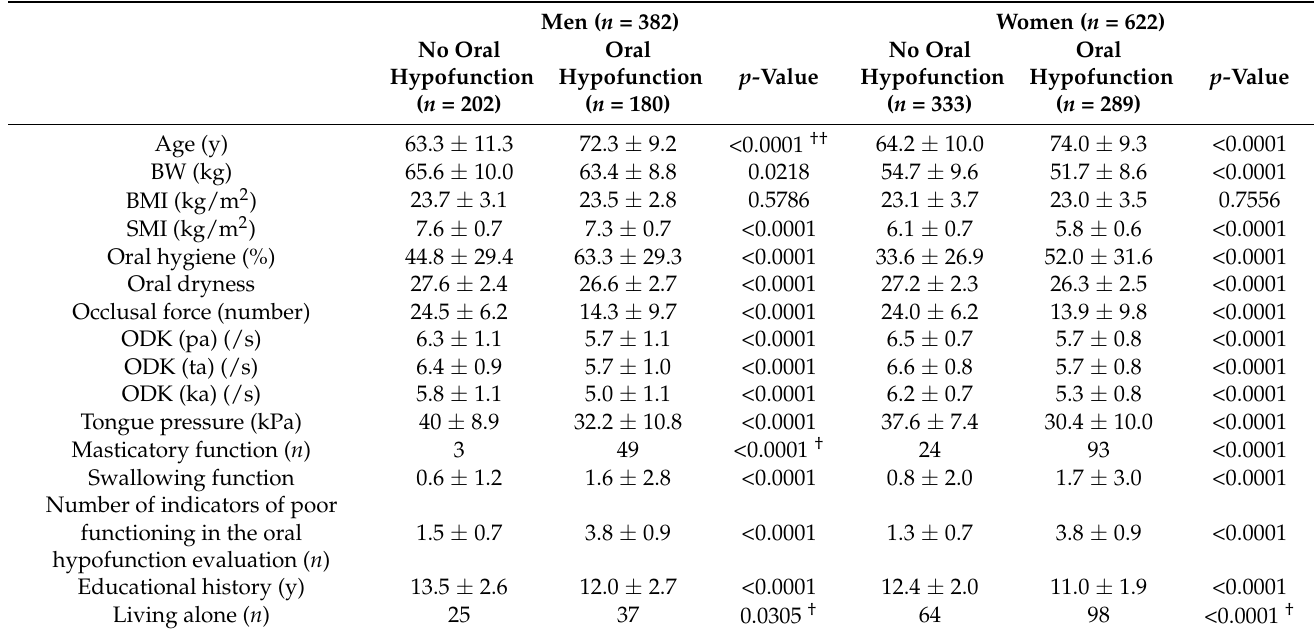
Table 2. Physical characteristics, examination results for oral hypofunction, and social background in groups with and without oral hypofunction by sex.